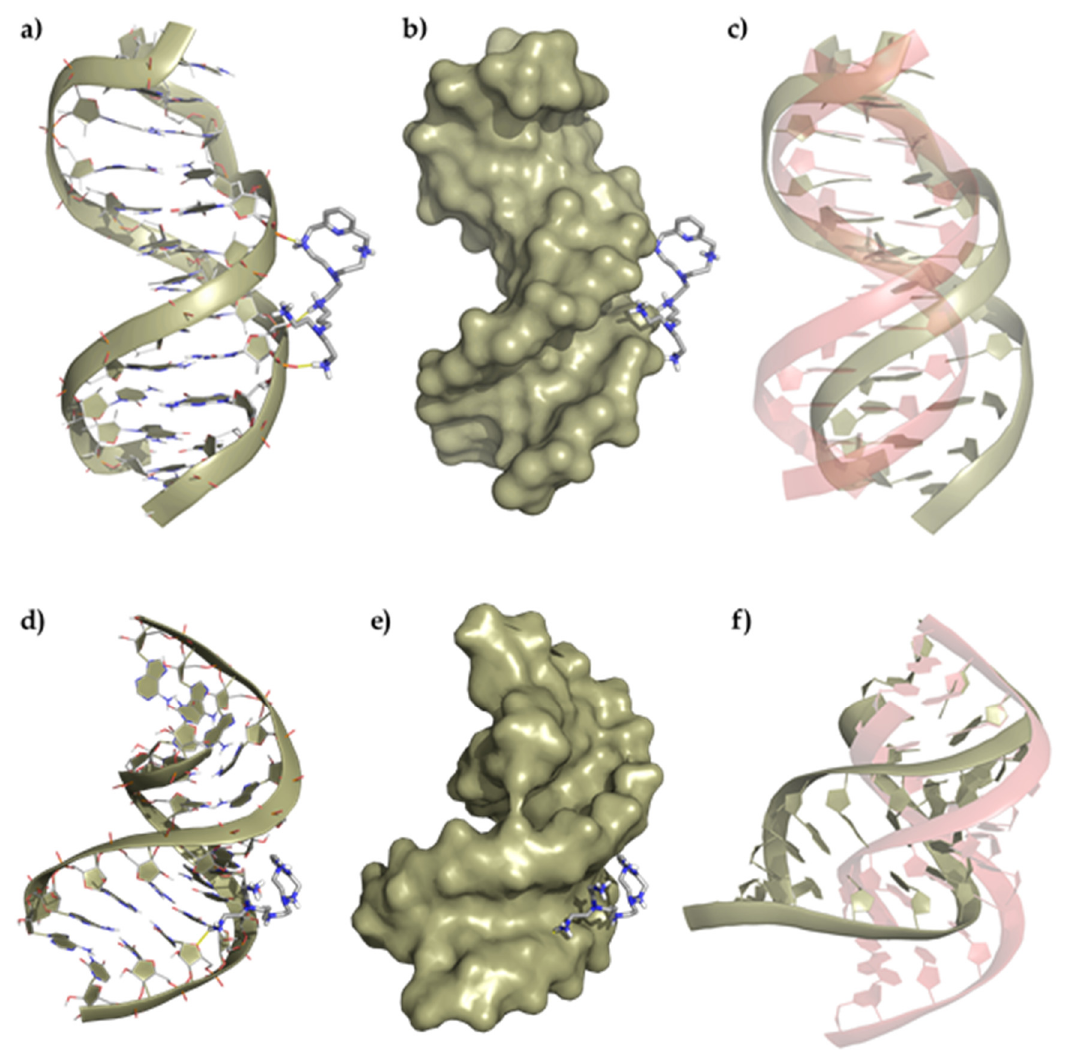
Figure 6. Top panel, representation of ( a ) the interaction of L1 with the ds-DNA, ( b ) the polynucleotide surface, and ( c ) deviation of the duplex DNA structure after interaction regarding its original conformation (represented in red). Bottom panel, representation of ( d ) the interaction of L1 with the duplex RNA, ( e ) the polynucleotide surface, and ( f ) deviation of the ds-RNA structure after interaction regarding its original conformation (represented in red).